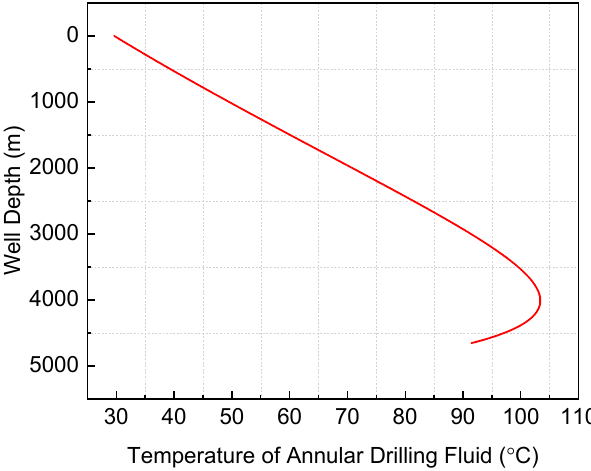
Figure 12. Variation curve of annular drilling fluid temperature with well depth.